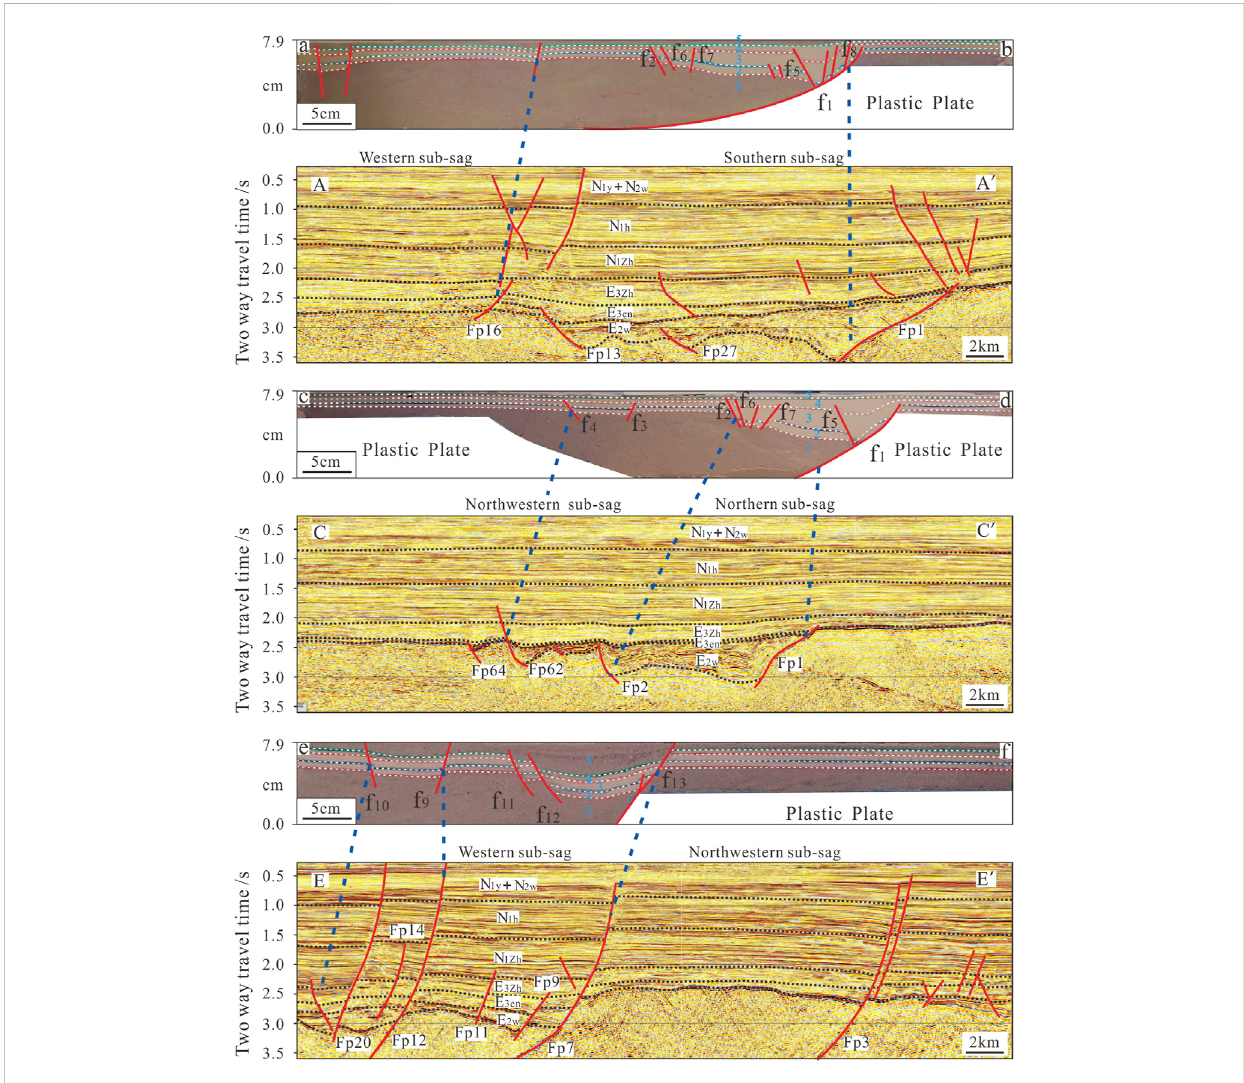
FIGURE 12 ComparisonbetweenmodelingresultsandinterpretationofseismicsectionsacrossthePanyu4Sag.Photographandlinedrawingofacrosssection in Model (for the location, see Figure 11Ch); interpreted seismic sections across the Panyu 4 Sag (for the location, see Figure